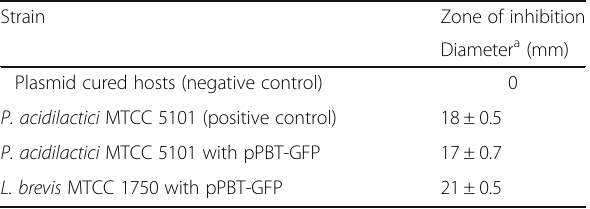
Table 4 Zone of inhibition of pediocin against E. faecium Strain Zone of inhibition Diameter a (mm) Plasmid cured hosts (negative control)